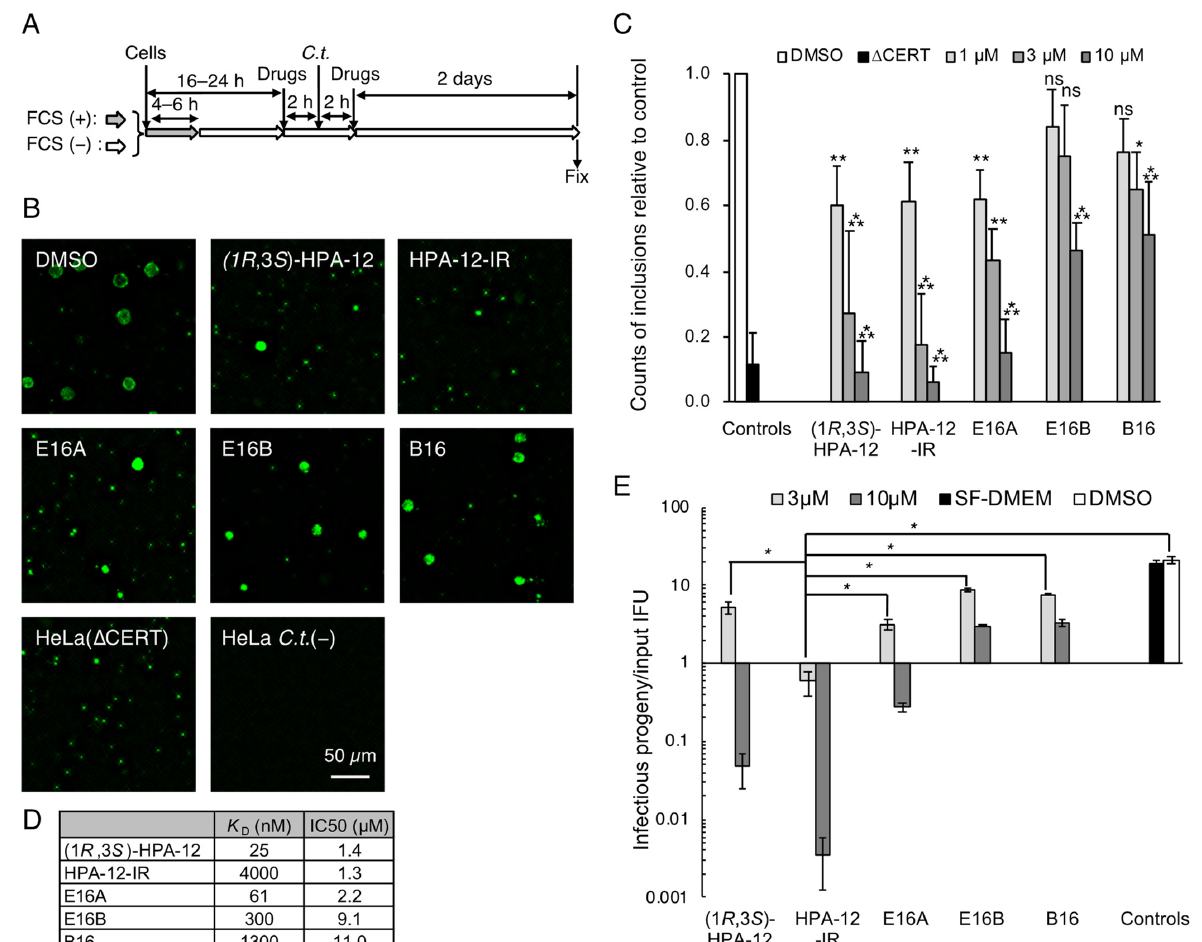
Figure 2. Repression of C. trachomatis proliferation by isomers of HPA-12 that possess CERT inhibitory activity and those that lack CERT inhibitory activity. ( A ) Schematic diagram of the experiment designed to measure the IFUs. The cells were maintained in SF-DMEM, pretreated with 10 μ M of the indicated compound for 2 h, infected with C. trachomatis for 2 h at an MOI of 0.5, and cultured in SF-DMEM containing 10 μ M of the compound for 2 days. Next, the cells were fixed and stained with FITC-conjugated anti-chlamydial LPS antibody. ( B ) Immunostaining pattern of chlamydia-infected HeLa cells treated with the compound as described above. The representative fluorescence micrographs of three independent experiments are shown. Scale bar, 50 μ m. ( C ) Concentration-dependent decrease in IFUs mediated by the compounds. The cells were treated as described above, except for the use of various concentrations of each compound. In order to calculate the IFUs, FITC-positive spots with an area >50 μ m 2 were counted using ImageJ software. The data represent the mean ± SD of triplicate experiments. Statistically significant values were compared to the DMSO control by Dunnett’s test (* p < 0.05; ** p < 0.01; *** p < 0.001; ns, not significant). ( D ) Summary of the inhibitory effects of the compounds. The K D values of the compounds for CERT were reported previously [18]. The IC 50 values for chlamydial primary IFUs were calculated by logistic regression with ImageJ software using the data shown in panel C. ( E ) Progeny formation assay of chlamydia-infected cells treated with each compound. HeLa cells were infected with C. trachomatis and treated with each compound, as described above. At 2 days post-infection, the cells were lysed with sterilized water and fresh confluent HeLa cell monolayers were infected with the lysates. The number of total infectious progeny was divided by the input IFU to generate the reproduction rate. The experiments were performed in triplicate and the data (mean ± SD) are shown with a logarithmic display in this panel. A two-tailed paired Student’s t -test with a Bonferroni correction between the groups of cells treated with DMSO and 3 μ M of compounds was performed (* p < 0.01).